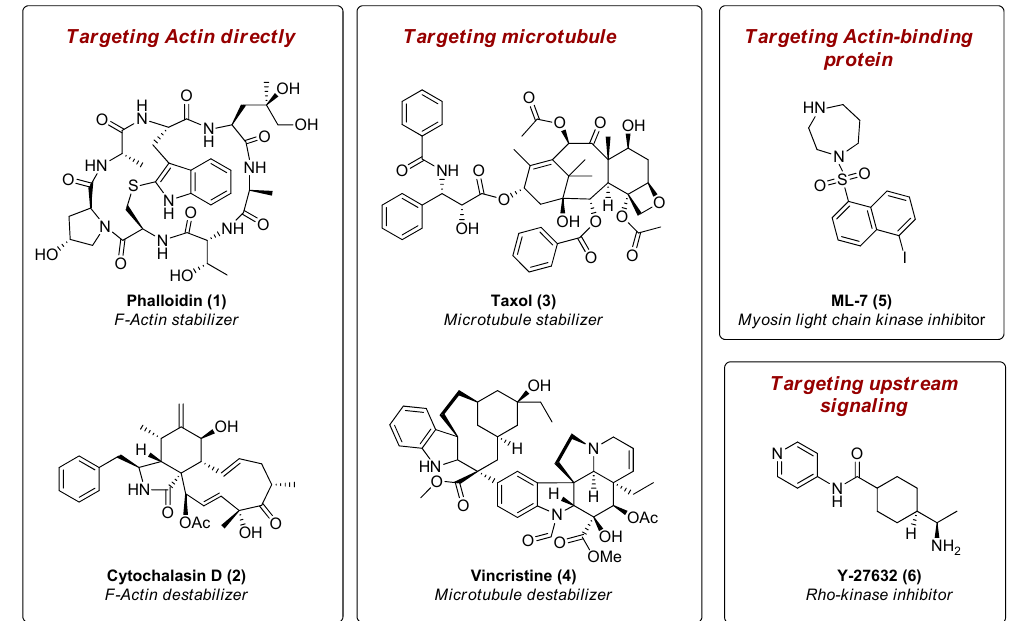
Figure 1. Small-molecule inhibitors of cell mobility.